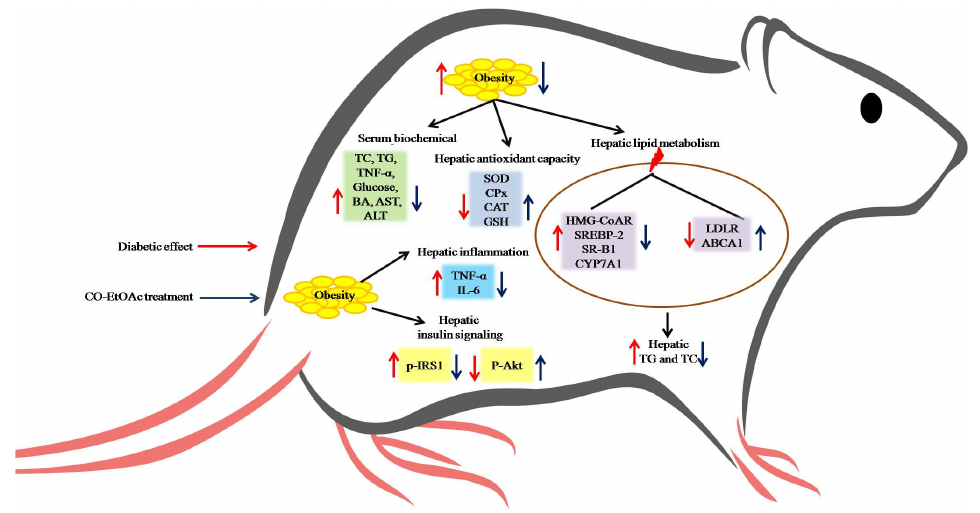
Figure 6. The potential mechanisms of CO-EtOAc protect metabolic dysfunction.